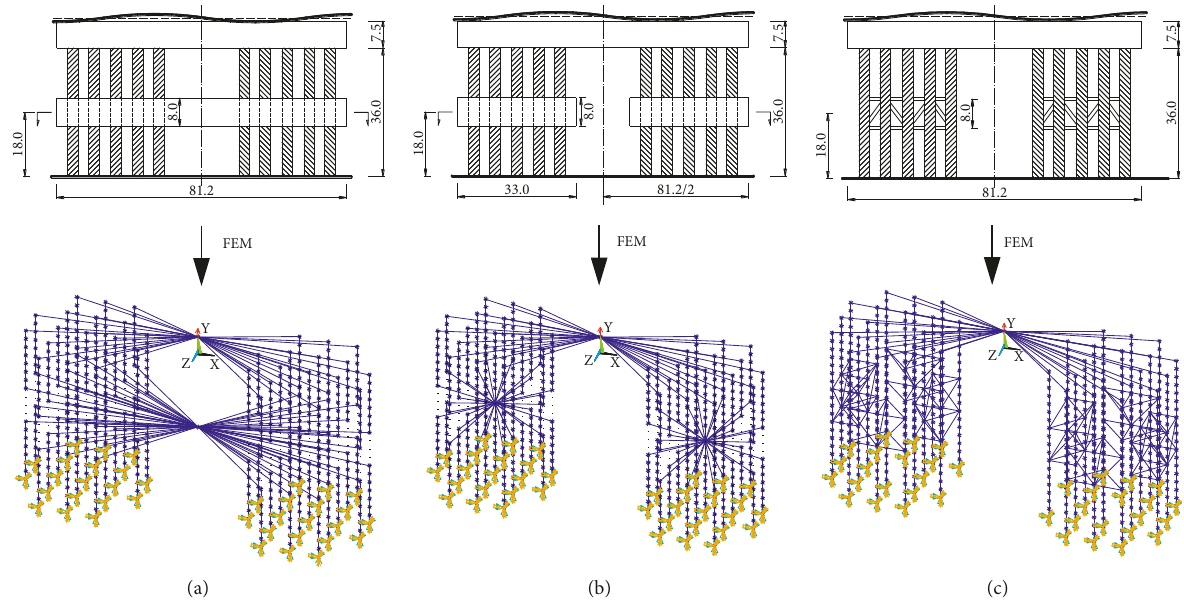
Figure 11: Optimized foundations (unit: m). (a) The double caps foundation. (b) The three caps foundation. (c) The joint piles foundation. Table 1: Dynamic characteristics of the foundations with different forms Mode